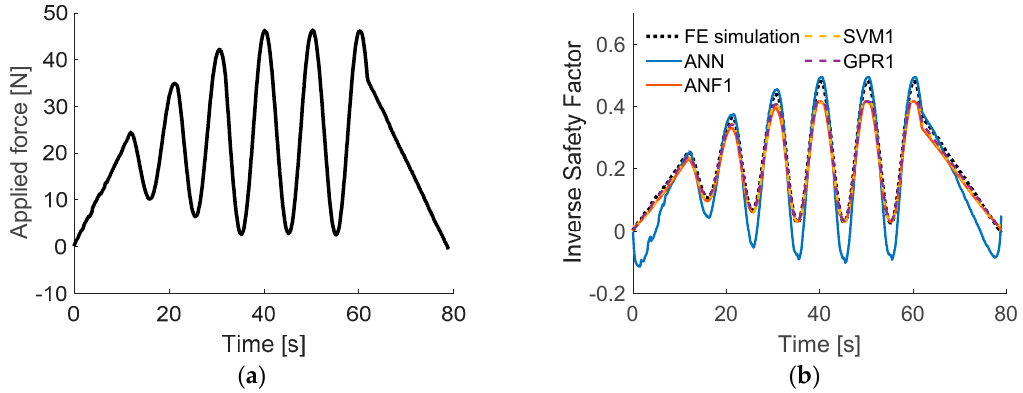
Figure 15. Results of testing chosen models with experimental input from supplementary S8 of [15]: ( a ) time plot of the applied force; ( b ) time plots of the ISF obtain from different models.